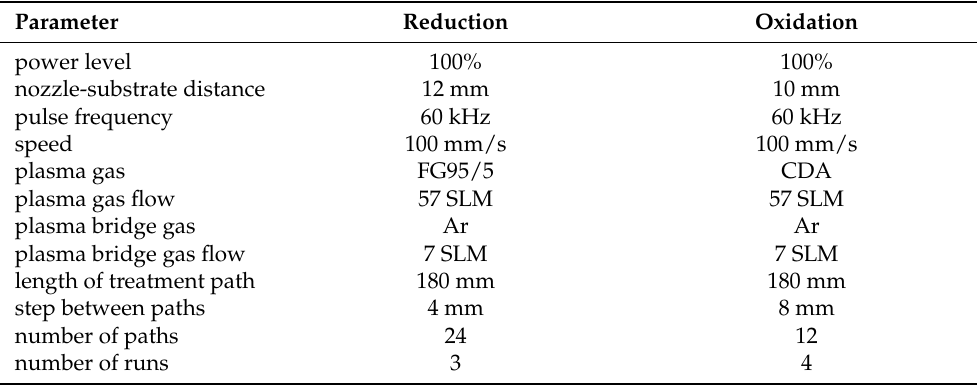
Table 2. The standard process parameters for reduction and pre-oxidation of copper contact pads o an A 2 O 3